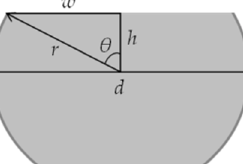
Figure 2. Image of a D-shaped fiber, where d is the fiber diameter, r the radius, h the depth, and w the half width of the sensing region.